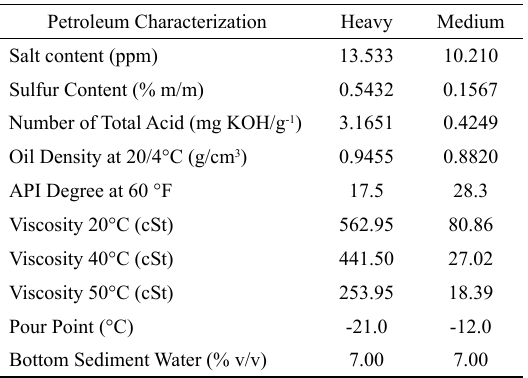
Table 1. Characterization of the heavy and medium petroleum samples. Petroleum